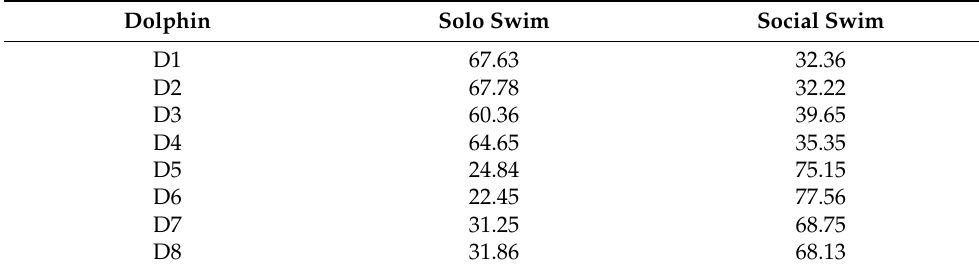
Table 2. Percentage of time spent in social and solo swim